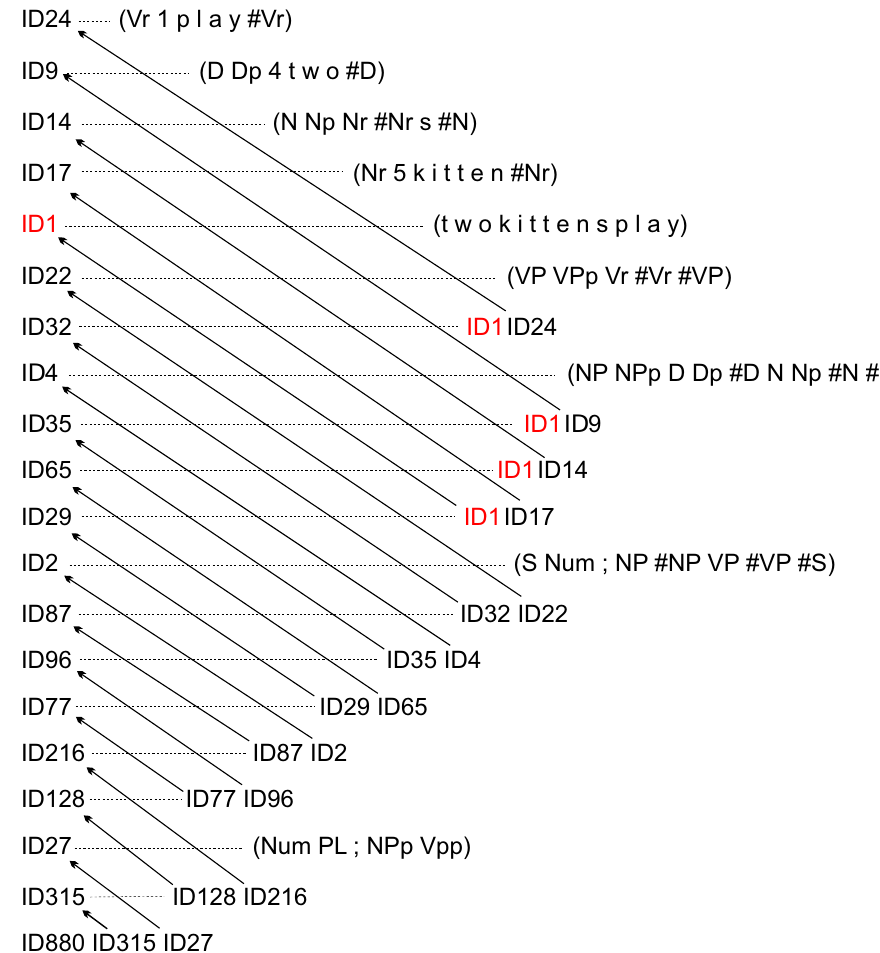
Figure 7. An audit trail for the creation of the SPMA shown in Figure A3. The line of text at the bottom of the figure shows, on the left, the identification number for the SPMA shown in Figure A3. To the right of that number are IDs of the two SPMAs from which the SPMA was derived. From each of latter two IDs, there is an arrow pointing to the same ID at the beginning of a line above. As before, this ID represents an SPMA, and to the right of that ID are two more IDs representing the two SPMAs from which the main ID for that line was derived. The remaining lines in the figure are the same except that, at higher levels, we begin to meet IDs that represent Old SP-patterns supplied to the SPCM at the beginning of processing. With the identifier ‘ID1’, there are five instances in the figure (each one shown in red), so to avoid undue clutter, only one arrow is shown. Reproduced from Figure 6 in [26], with